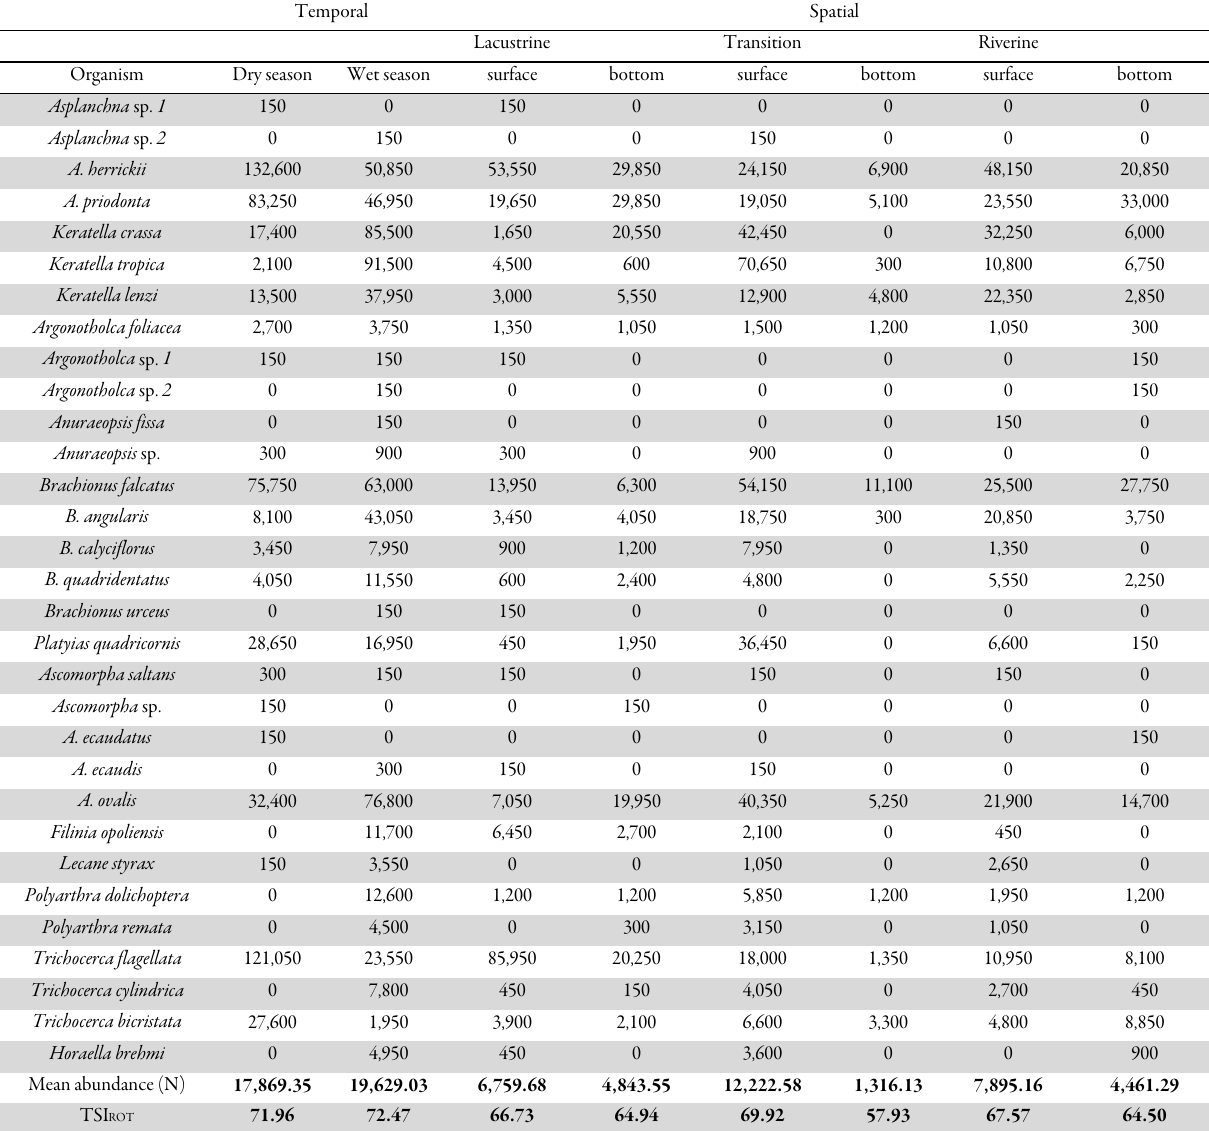
Table 8. Estimation of Trophic State Index using Rotifer